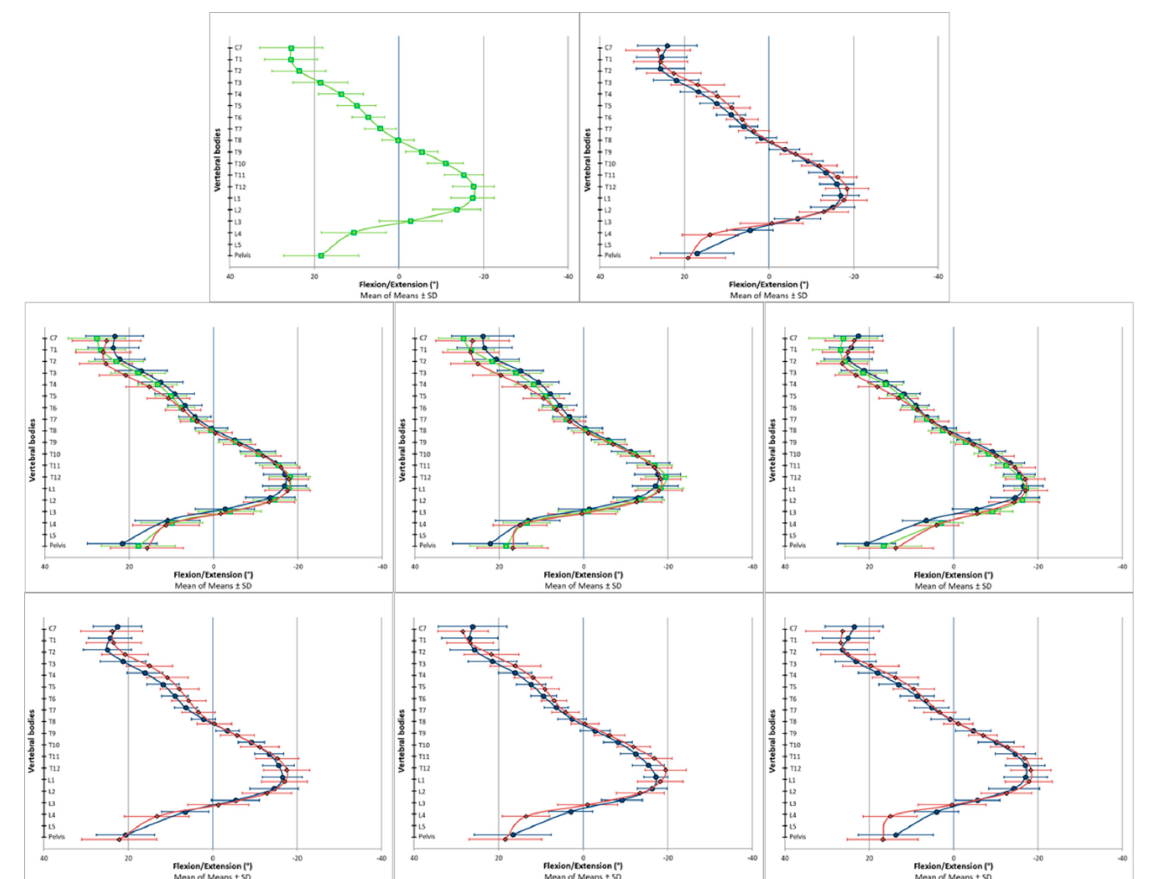
Figure 4. Vertebral body positions in the sagittal plane. Positive values represent a tilt of the vertebral bodies towards spinal flexion, and negative values represent a tilt of the vertebral bodies towards spinal extension. The scale of the x -axis is turned to enhance the intuitive visual interpretability of the results: Upper row (left picture: all participants ( ◼ , green); right picture: all female ( ◆ , red) and all male ( ● , blue) participants). Middle row (left picture: all participants of the respective age cohorts: young ( ● , blue), middle ( ◼ , green) and old ( ◆ , red); middle picture: all female participants of the respective age cohorts: young ( ● , blue), middle ( ◼ , green) and old ( ◆ , red); right picture: all male participants of the respective age cohorts: young ( ● , blue), middle ( ◼ , green) and old ( ◆ , red)). Lower row (left picture: all young female ( ◆ , red) and all young male ( ● , blue) participants; middle picture: all middle-aged female ( ◆ , red) and all middle-aged male ( ● , blue) participants; right picture: all old female ( ◆ , red) and all old male ( ● , blue) participants.